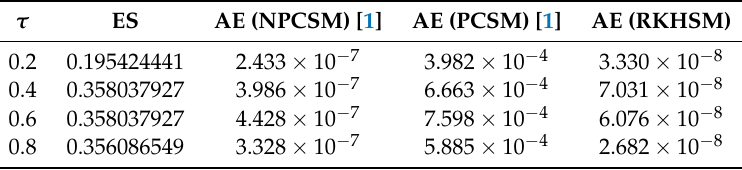
Table 1. Exact solution (ES) and absolute errors (AE) of Example